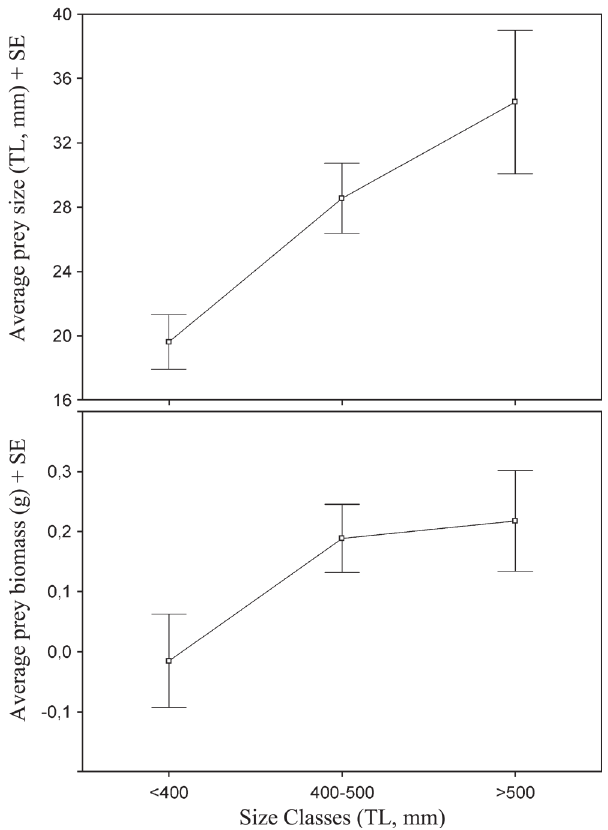
Fig. 3. Average values (±SD) of prey’s size (mm, TL) and biomass (g) in the stomach content of three size classes (<400 mm TL; 400-500 mm TL; >500 mm TL) of the dusky grouper Mycteroperca marginata . The number of individuals analyzed in each size class is 29, 34 and 15,